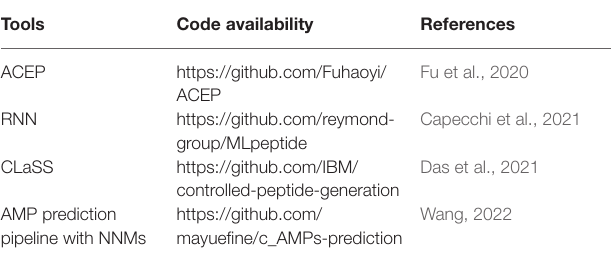
TABLE 2 | The code availability for prediction of antimicrobial peptide (AMP) discovery.